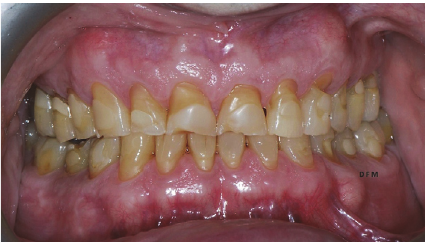
Figure 1: Intraoral preoperative conditions. Notice widespread cervical abrasions and abfractions.